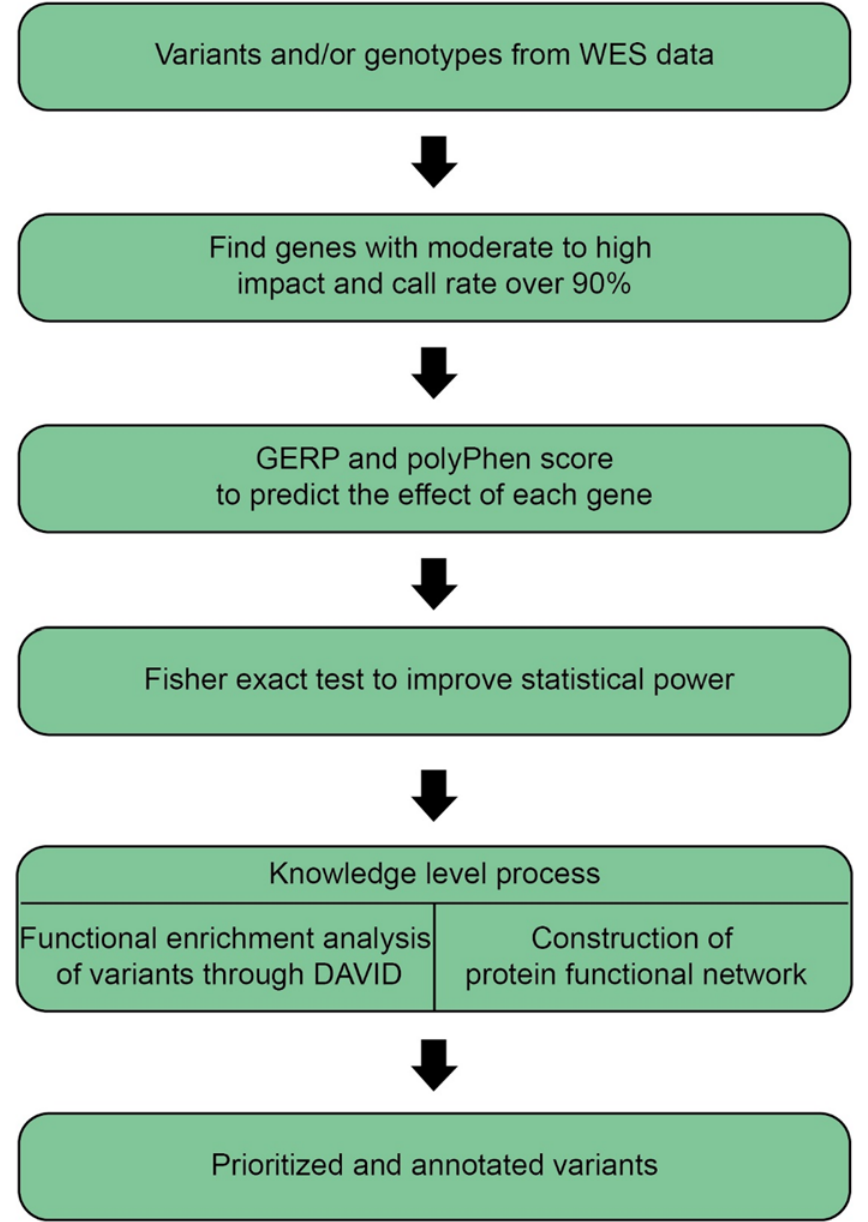
Fig 1. An outline of variant selection for data